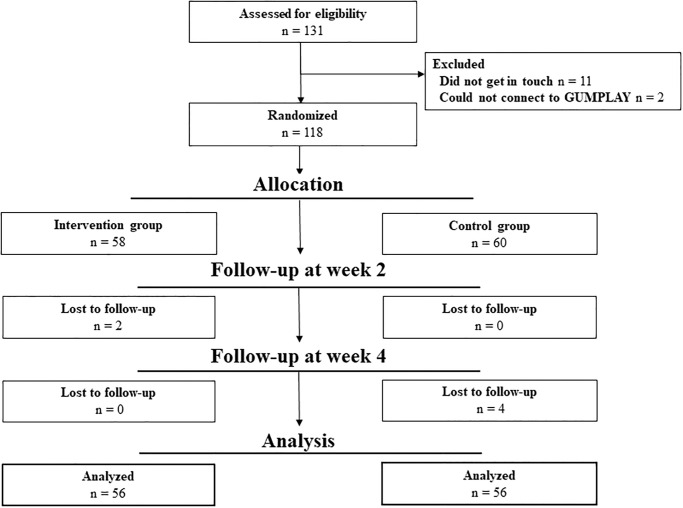
Participant flow in this trial.